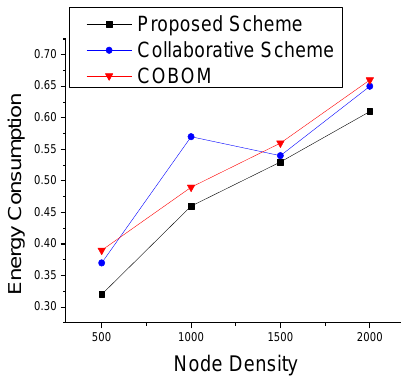
Figure 13. Normalized energy consumption with different node densities.